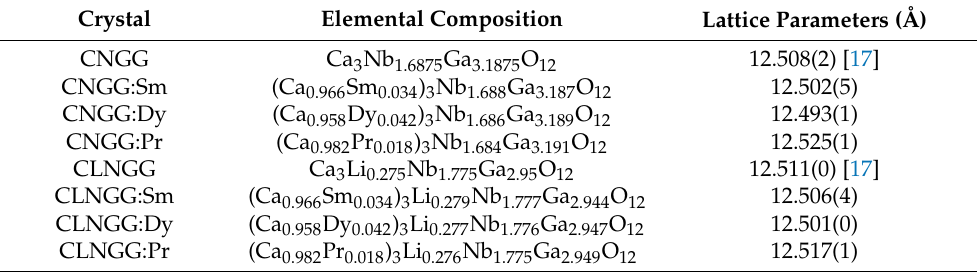
Figure 2. XRPD patterns of CNGG:RE and CLNGG:RE (RE = Sm, Dy, Pr) grown crystals. (Reprinted with permission from Ref. [47], copyright 2018, Elsevier). Table 1. Elemental compositions and lattice parameters of CNGG:RE and CLNGG:RE (RE = Sm, Dy, Pr) grown crystals. (Reprinted with permission from Ref. [47], copyright 2018, Elsevier).